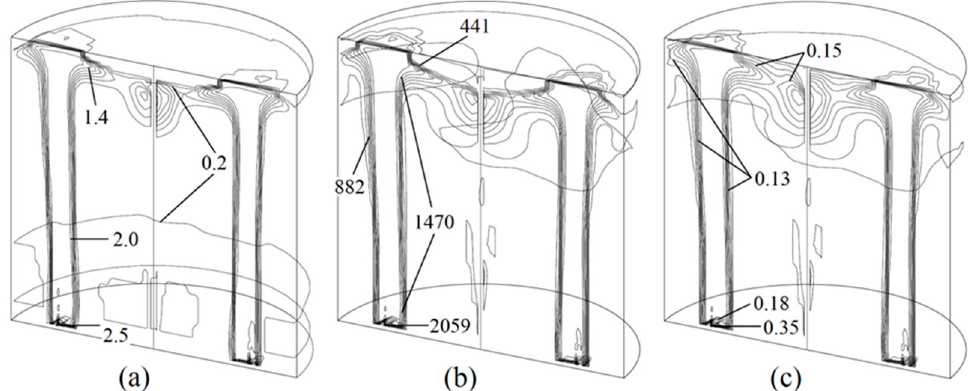
Figure 8. Single plug gas injection (one nozzle) simulation: Gas-bubble characteristics in the system: ( a ) Weber number, ( b ) Reynolds number and ( c ) Slip velocity in m/s.